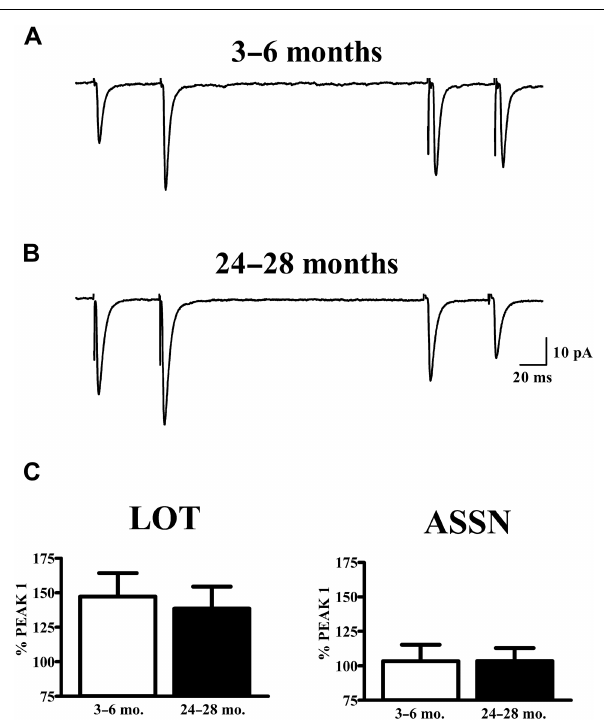
FIGURE 3 | Paired-pulse characteristics inAPC at LOT andASSN synapses are unaffected by aging. (A,B) Evoked LOT (left traces) and ASSN (right traces) paired pulse responses from principal cells in layer II of APC were collected from young (3–6 months, n = 18) and old (24–28 months, n = 11) mice at –80 mV. Cells were only included in analysis if recordings were obtained from both LOT and ASSN inputs. Paired-pulse stimulation (50 ms ISI) was presented to LOT fibers followed by the same stimulation to ASSN fibers one second later. Currents were collected every 20 s and the representative traces illustrated are an average of 50–100 stimulations. (C) Normalized averages of the second response were generated by calculating the response amplitude relative to that of the first response. No differences in paired-pulse response at either LOT or ASSN synapses were detected between age groups.